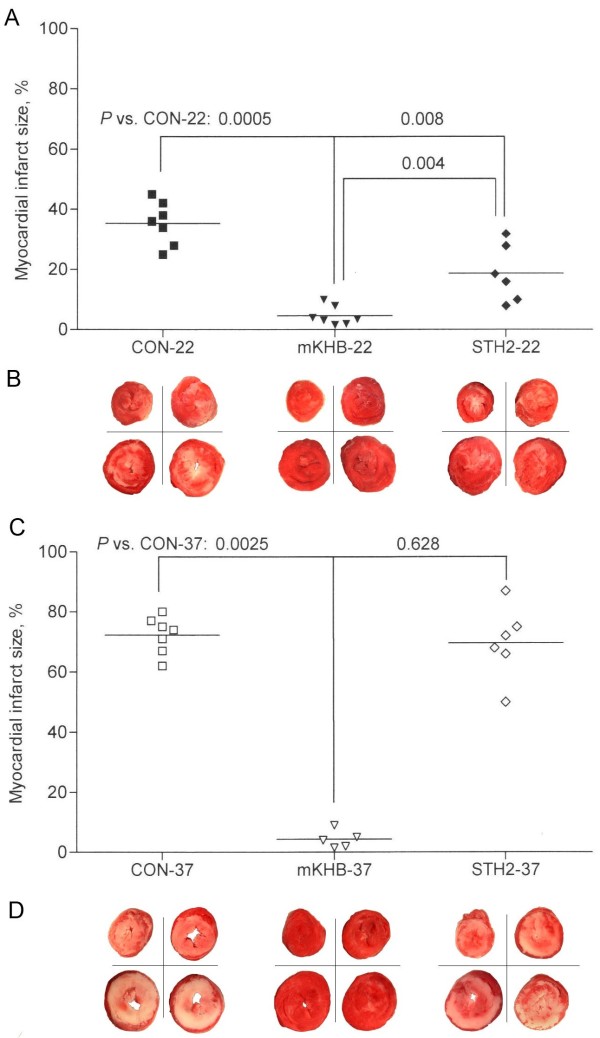
Myocardial infarct size after the 120-min reperfusion of the Langendorff-perfused rat hearts that were subjected to 60 or 180 min of global ischemia, sectioned, and stained with triphenyltetrazolium chloride. Infarct size in the hypothermia (A) and normothermia series (C). The data are presented as dot plots with median values. The triphenyltetrazolium chloride-stained heart slices selected from the representative experiments in each group in the hypothermia (B) and normothermia series (D). See Figure 1 for the group legends.